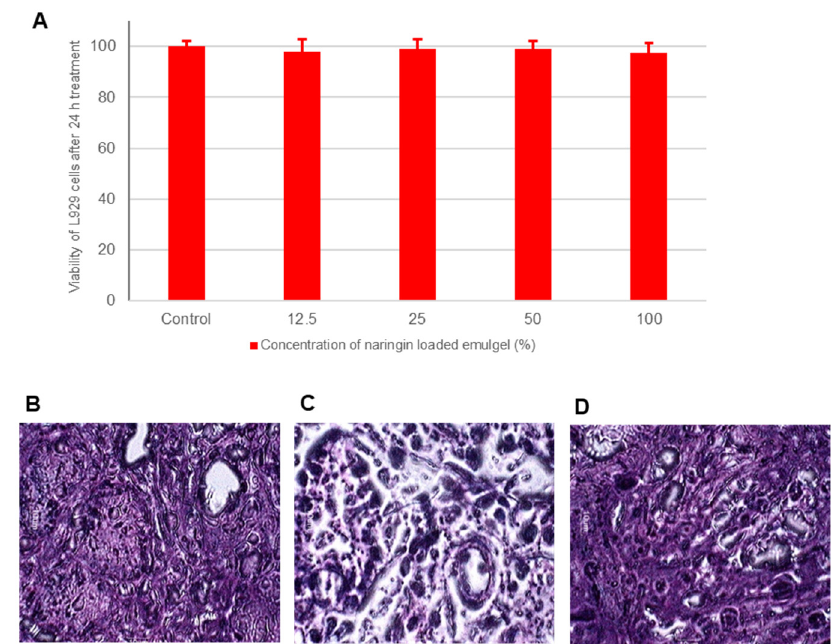
Figure 7. ( A ) Graph showing percentage viability versus concentration of nanoemulsion analyzed using MTT assay. Values are mean of six determinations. Error bars represent SD. Histopathological sections of nasal mucosa (100×) ( B ) Negative control: untreated mucosa, ( C ) Positive control: mucosa treated with nitric acid (37% v / v ) for 2 h and ( D ) Test specimen: mucosa treated with naringin in situ gelling nanoemulgel formulation for 6 h.